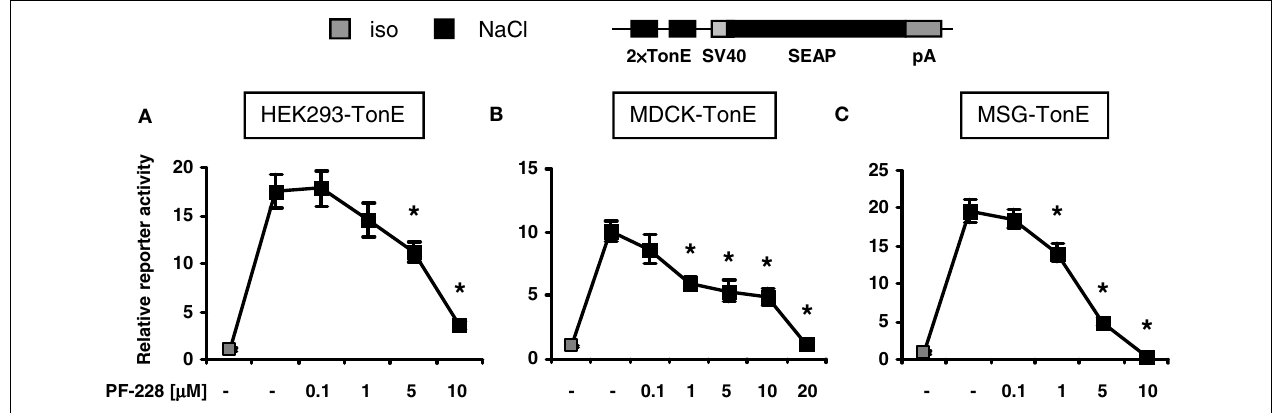
FIGURE 2 | Effect of FAK inhibition on TonEBP/NFAT5 activity. HEK293, MDCK, and MSG cells were transfected stably with a TonEBP/NFAT5-driven reporter construct [ HEK293-TonE , (A) ; MDCK-TonE , (B) ; MSG-TonE , (C) ]. The cells were incubated in isotonic medium (300mosm/kg H 2 O) or